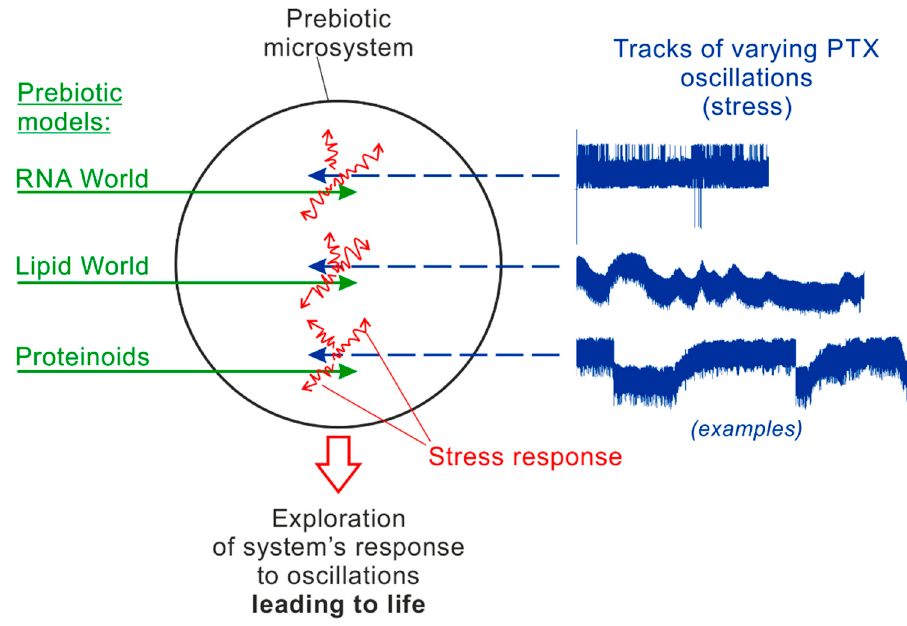
Figure 4. The scheme of the new direction of laboratory simulations on the origin of life based on the four required conditions.